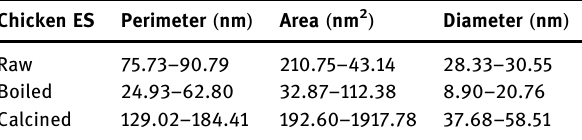
Table 2: Details regarding the porosity of ESs [ 17 ]